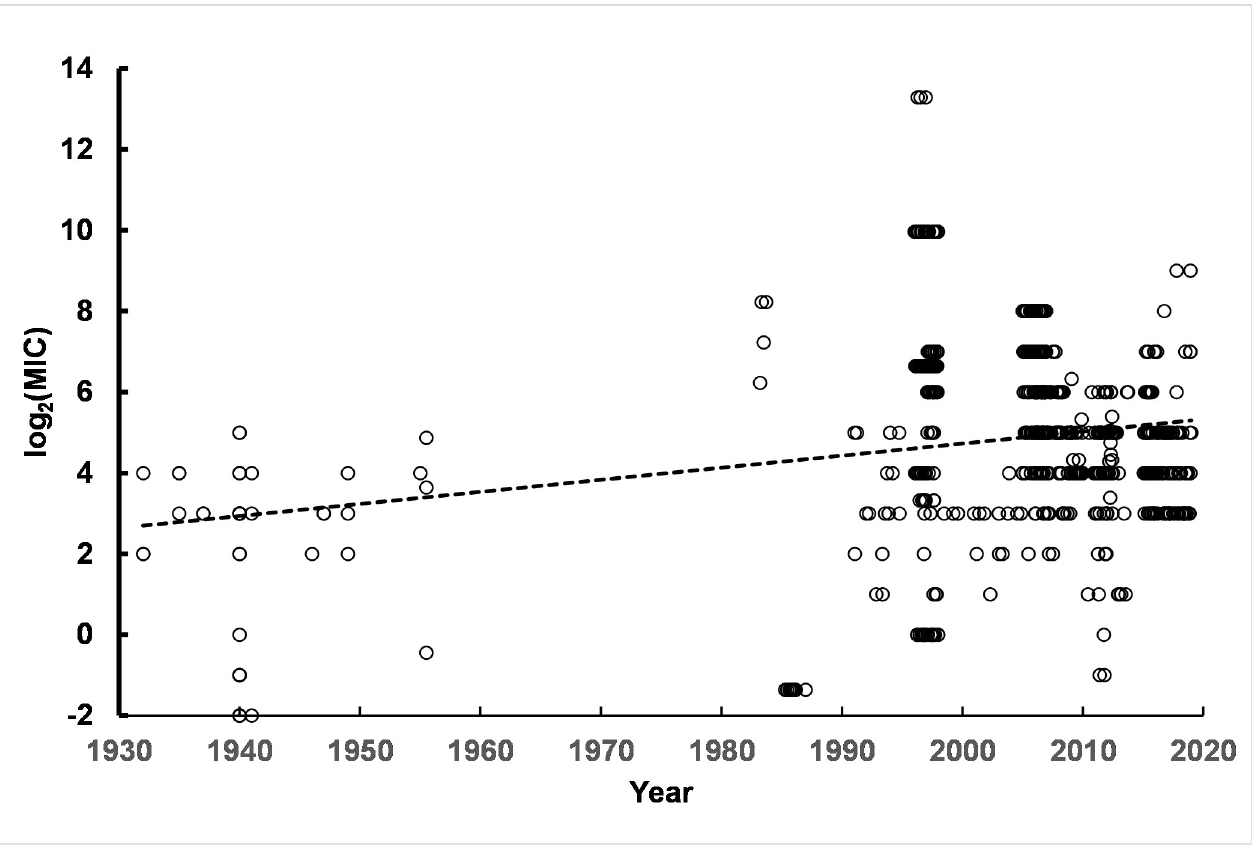
Fig 4. Time course of K . pneumoniae susceptibility to CHX. The results are from a single representative linear regression analysis from among 50 permutation runs. Details of linear regression parameters are given in S5 Table in S2 Appendix. Replicate permutations sampling within the range of uncertainties for isolation dates and MIC values as reported in the literature for the 21 studies compiled for this report indicated a small slope consistent with a small degree of decrease in susceptibility to CHX over the approximately 90 year time interval of isolation dates for K . pneumoniae strains.